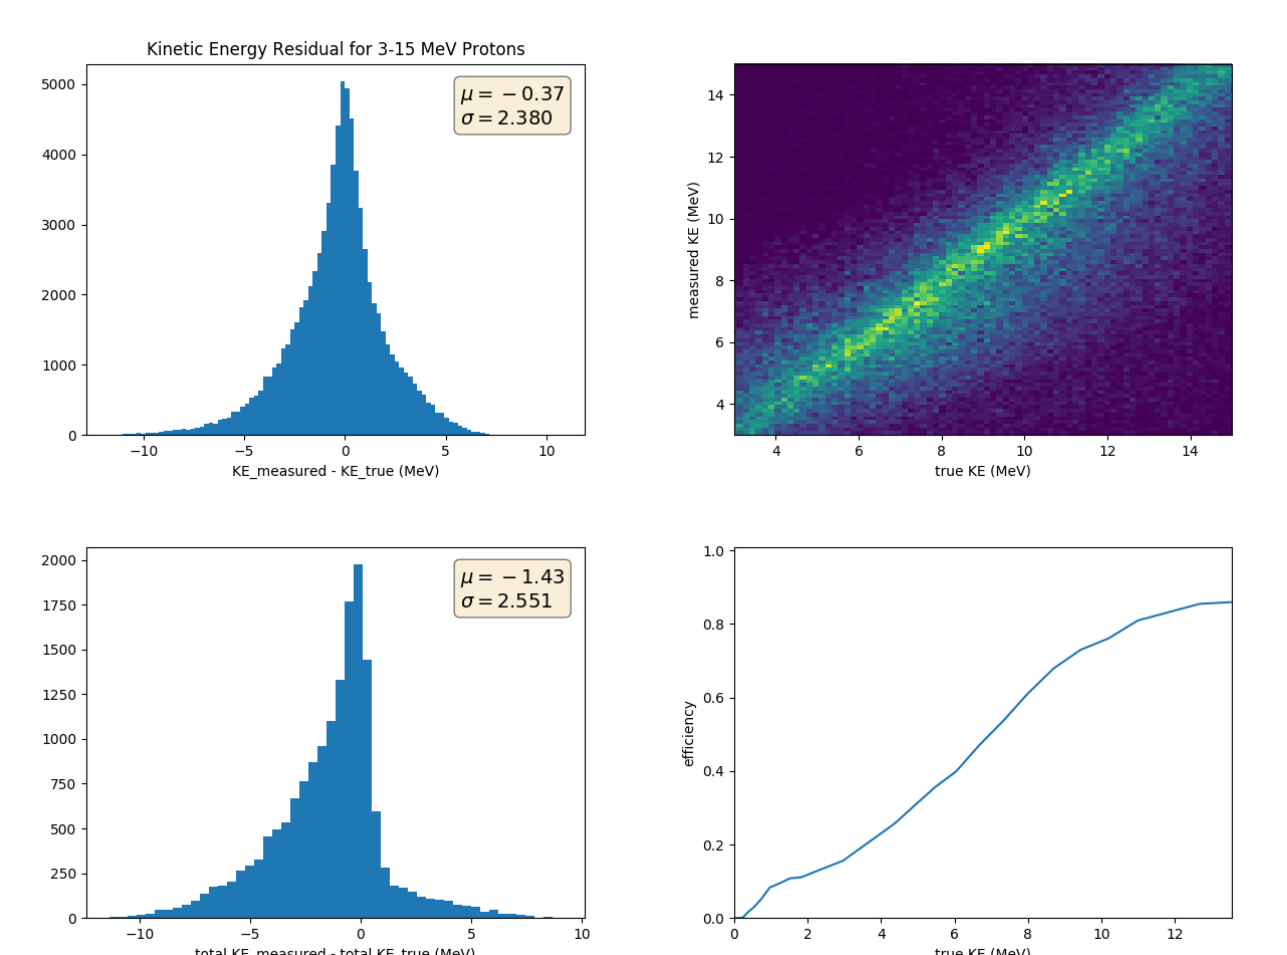
Figure 66. ( Top left ) Kinetic energy (KE) residual for reconstructed protons with KE in the range 3MeV to 15MeV. ( Top right ) Measured KE vs. true KE for the same energy range. ( Bottom right ) Reconstruction efficiency as a function of true KE. ( Bottom left ) Residual of the total KE of all protons in each event in the test sample. The asymmetric shape is due to protons which were not